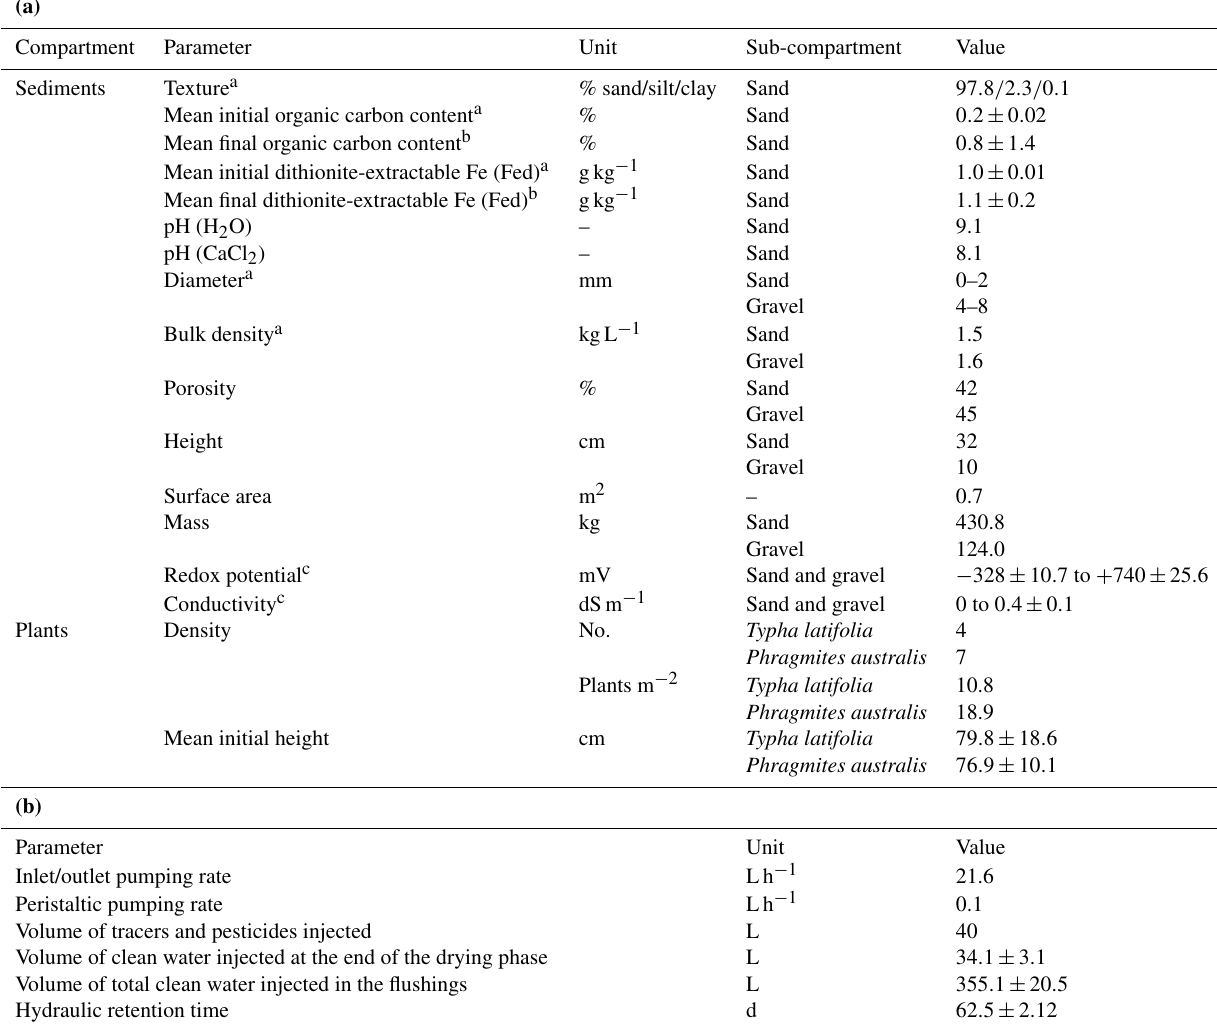
Table 2. (a) characteristics and (b) operation of the model constructed wetland system.